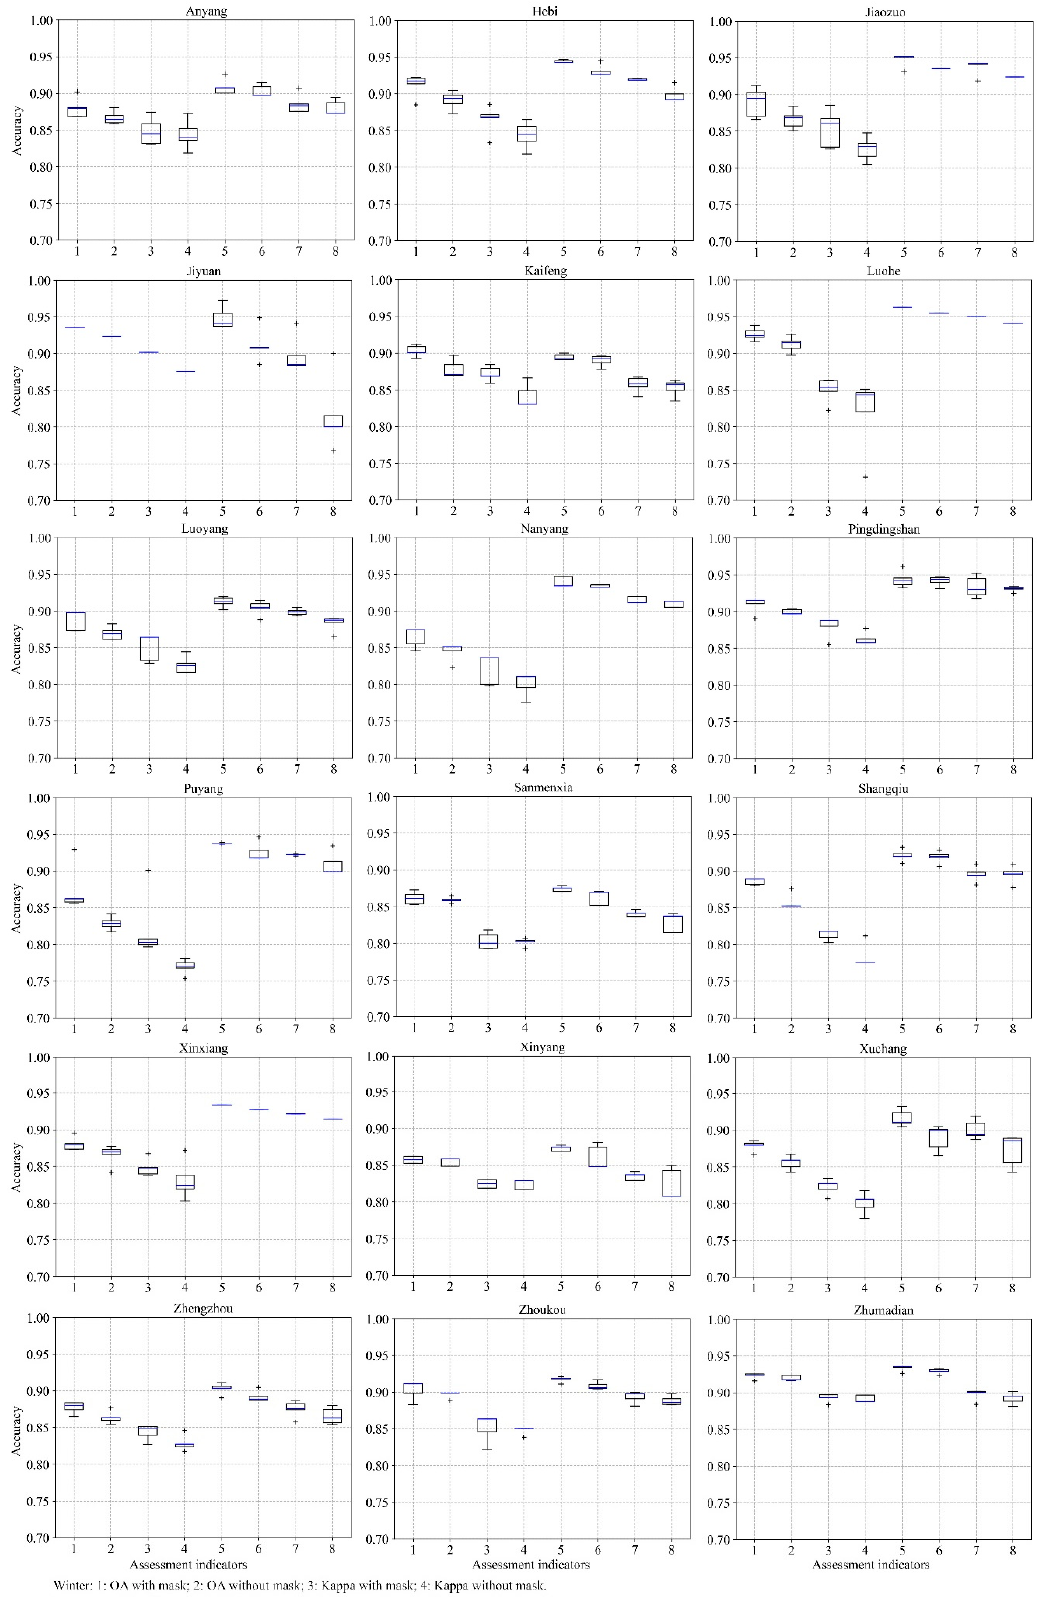
Figure 8. Changes in regional assessment indicators under multiple conditions.